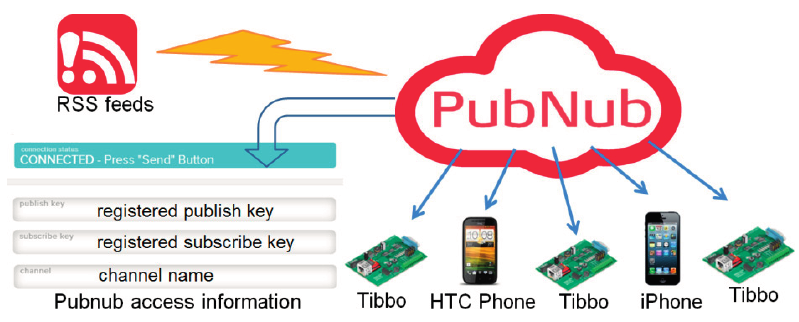
Figure 2. Deliver messages via PubNub.